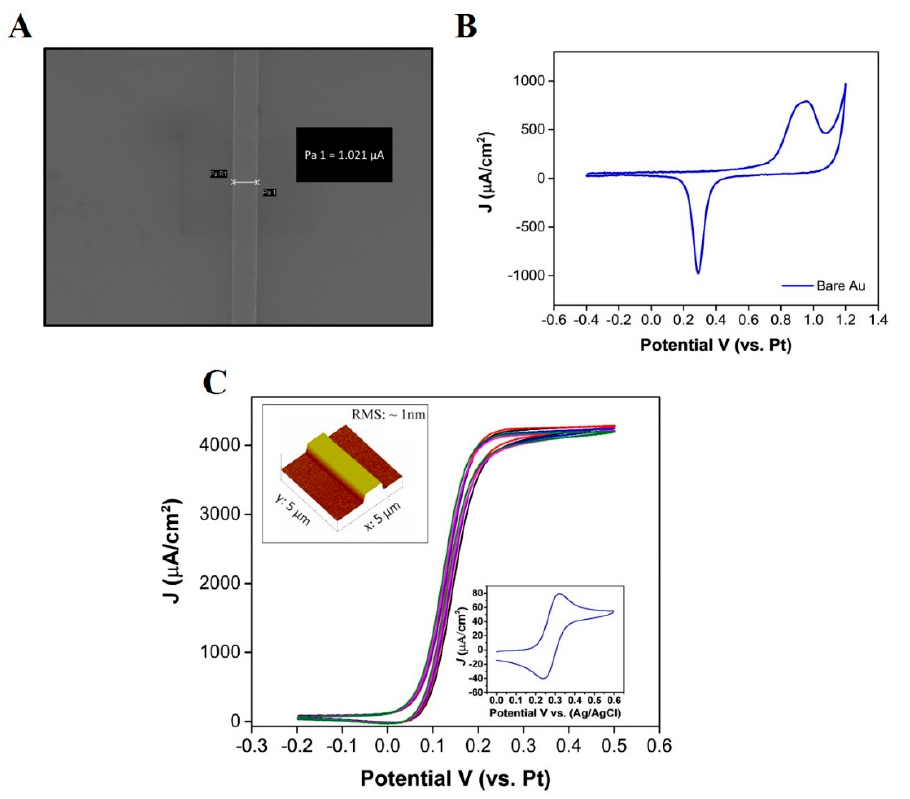
Figure 1. ( A ) SEM image showing a width measurement of 1.021 µ m, ( B ) cyclic voltammogram obtained in 0.1 M H 2 SO 4 at a scan rate of 50 mVs − 1 , and ( C ) cyclic voltammogram obtained in 1 mM FcCOOH for n = 5 electrodes on one chip (RSD < 0.1%), (inset graph shows a cyclic voltammogram obtained at a macro-Au band electrode), inset figure depicts a 3D atomic force microscopy image of a 5 µm × 5 µm area at a scan rate of 0.7 Hz (Background plane subtraction was applied to the image).